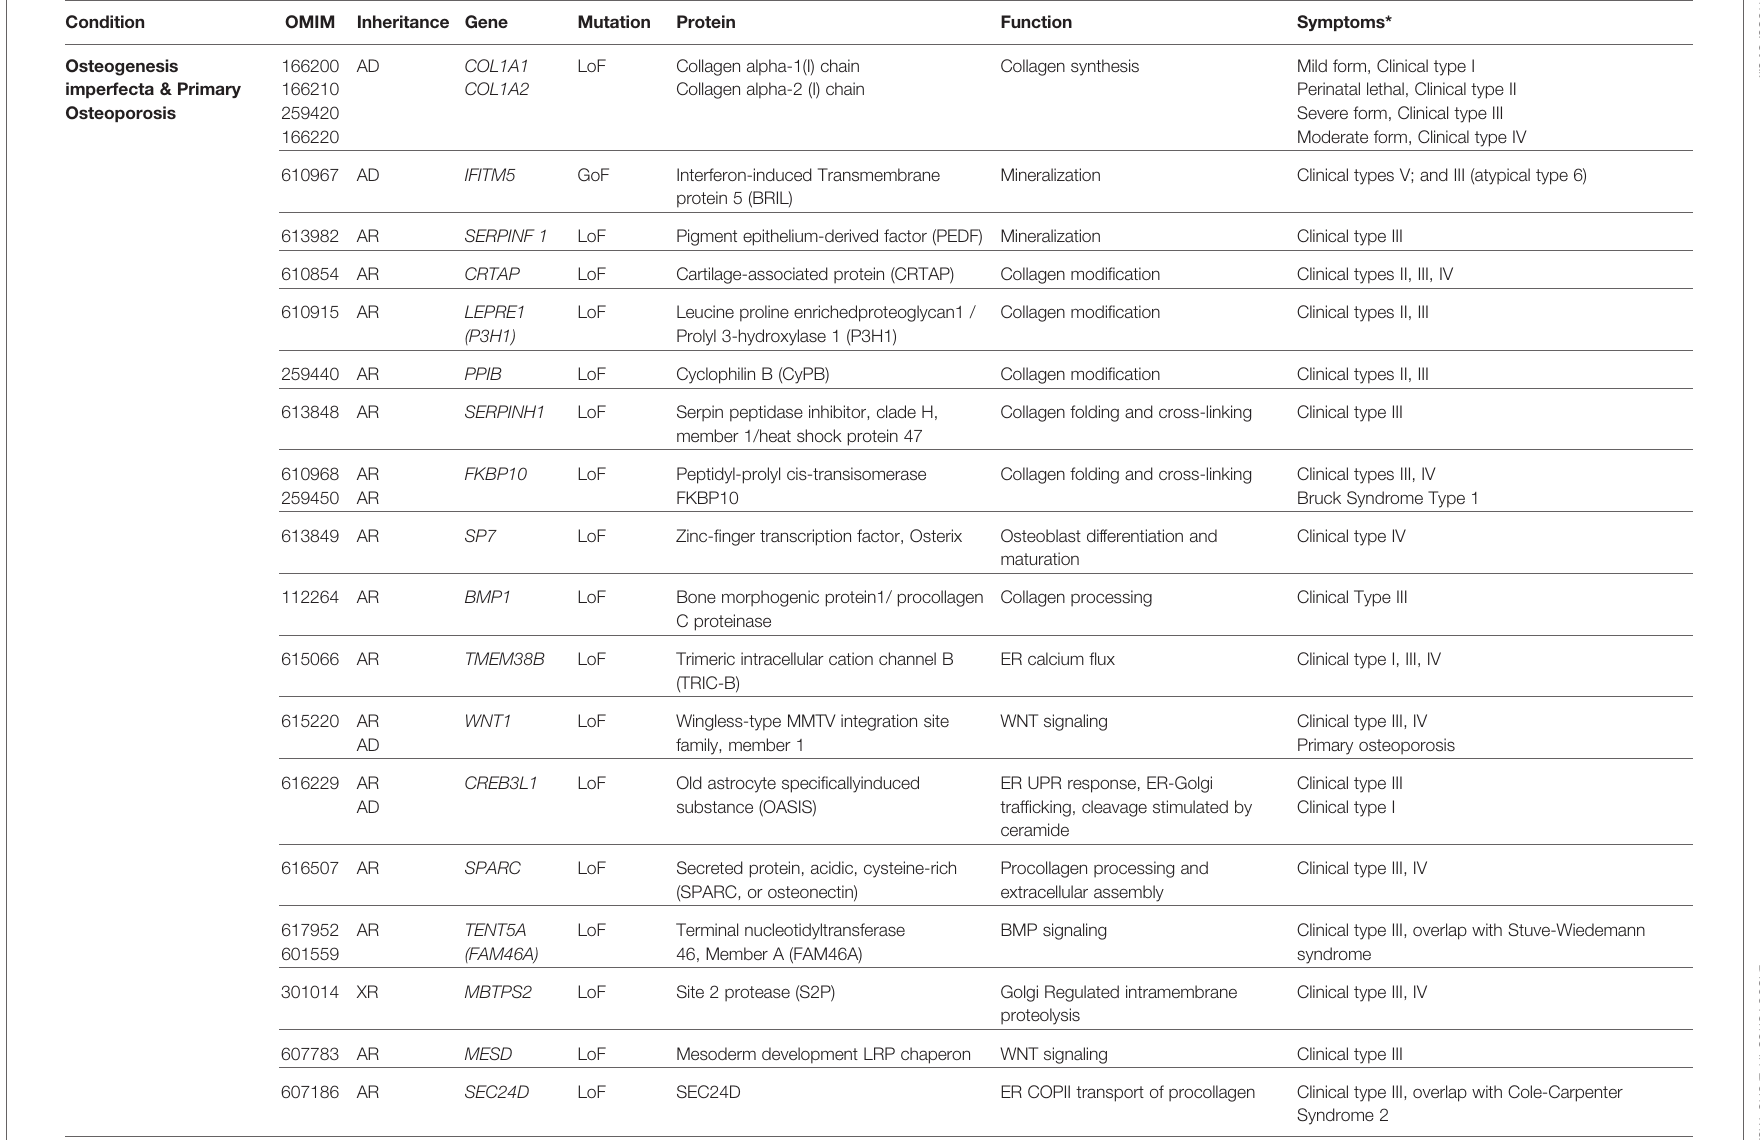
TABLE 1 | Bone fragility conditions with low and high bone mass; the gene defects, function and clinical